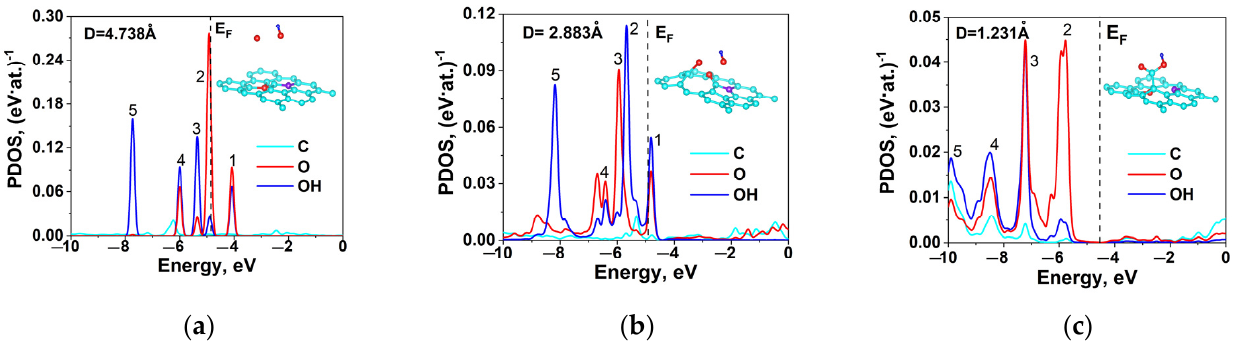
Figure 4. Repulsion energy of OOH group and tube surface E rep versus interatomic distance C=O with red curve for rigidly fixed C atom in surface layer, black curve for loose C atom, and inset for charge transfer on C, O, and OH versus interatomic distance C=O after relaxation for loose C.